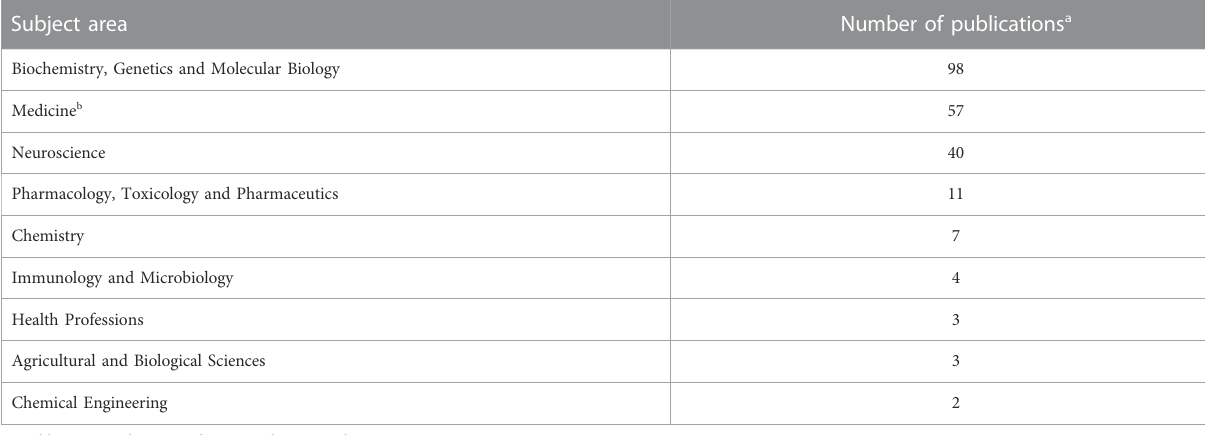
TABLE 2 Subject areas of the heme oxygenase-2-related publications published since 1990.